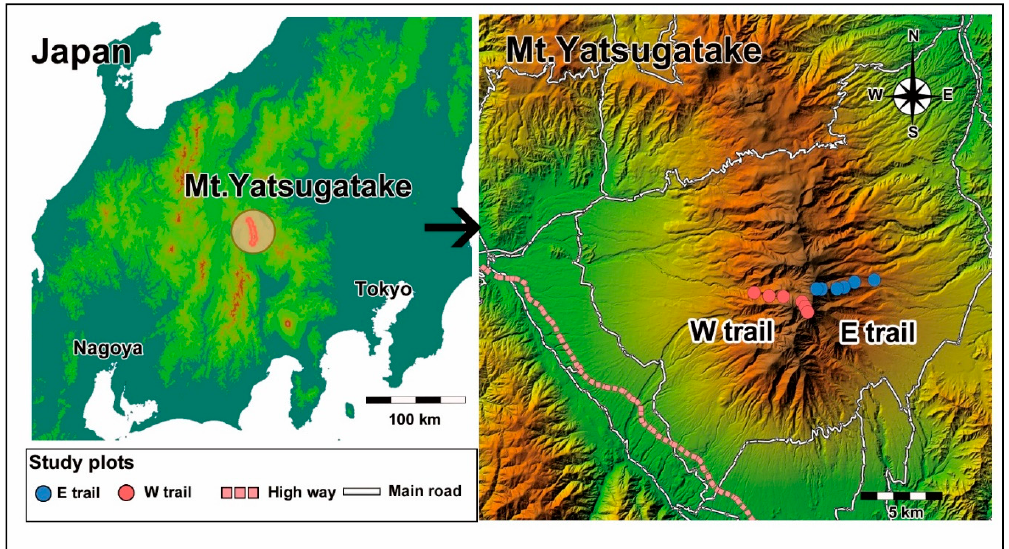
Figure 1. Study site, Mt. Yatsugatake, central Japan. The location of Mt. Yatsugatake is shown by the red circles in the slide on the left. Study plots were established along the E and W trails at 200-m altitude intervals, from 1800 to 2800 m. The left-hand panel was adapted from Figure 1 of Oishi [39]. The right-hand panel was created using global information system data provided by the Ministry of Land and Geospatial Information Authority of Japan.